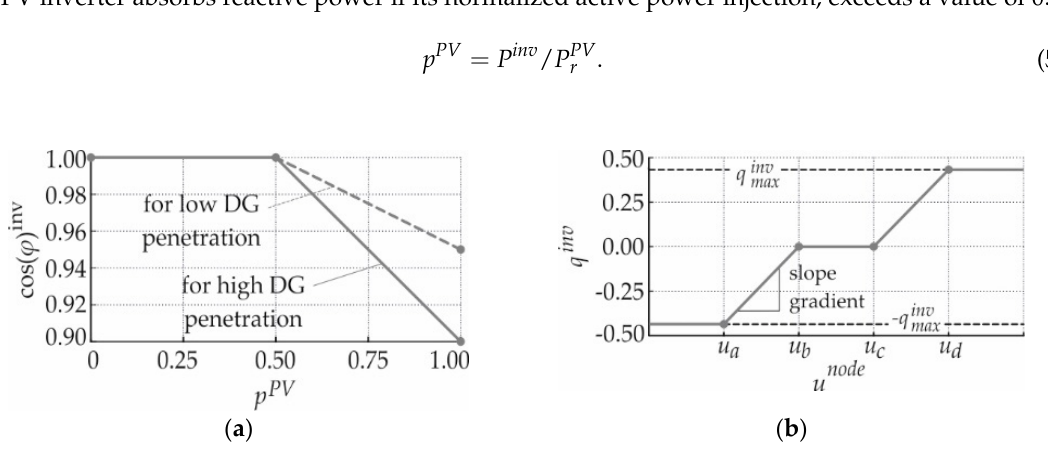
Figure 5. Fundamental characteristics of different local control strategies for PV-inverters